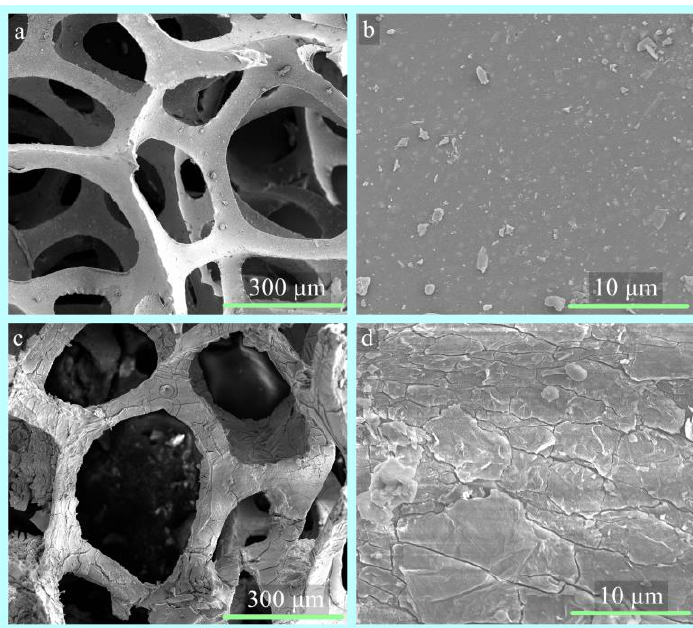
Figure 9. The SEM images of the ( a , b ) PUS and ( c , d ) modified PUS.